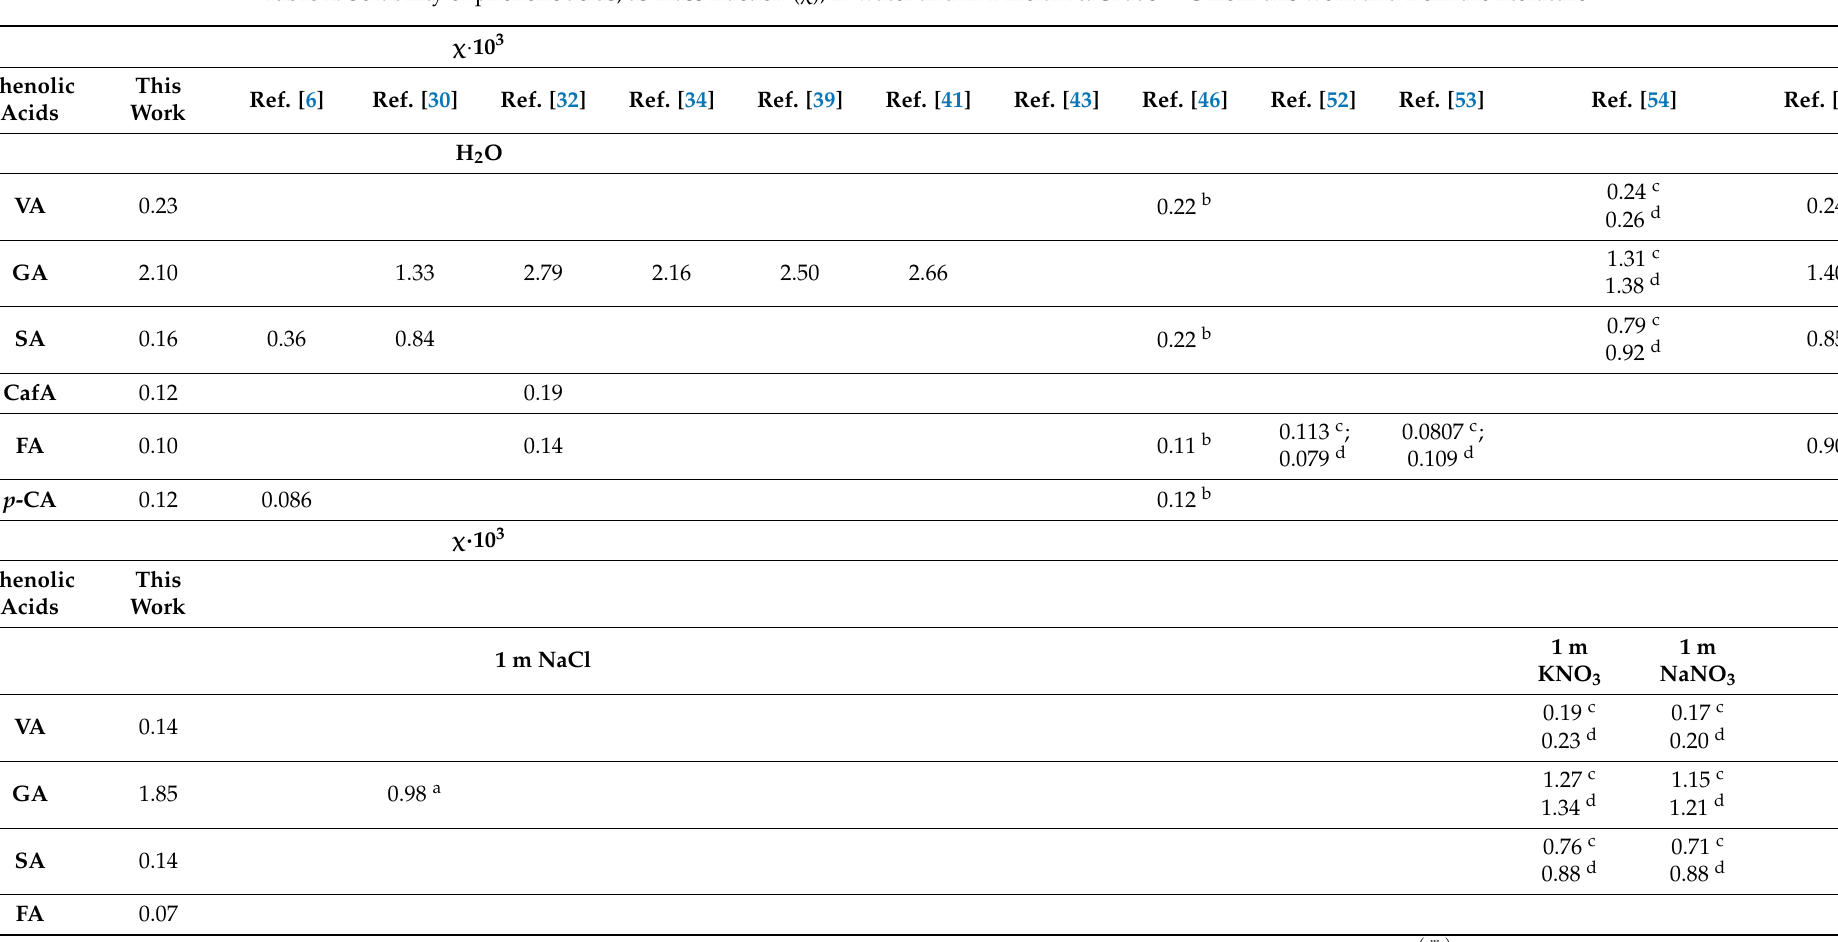
Table 2. Solubility of phenolic acids, as mass fraction ( χ ), in water and in 1 molal NaCl at 37 ◦ C from this work and from the